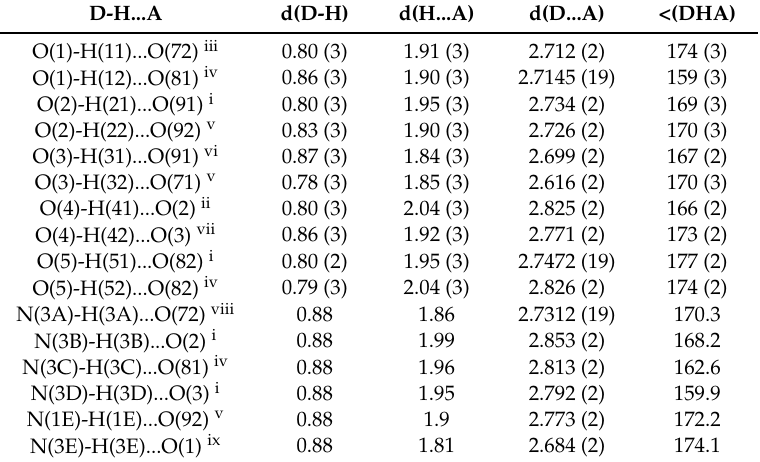
Table 2. Hydrogen bonds for M1 (Å) and ( ◦